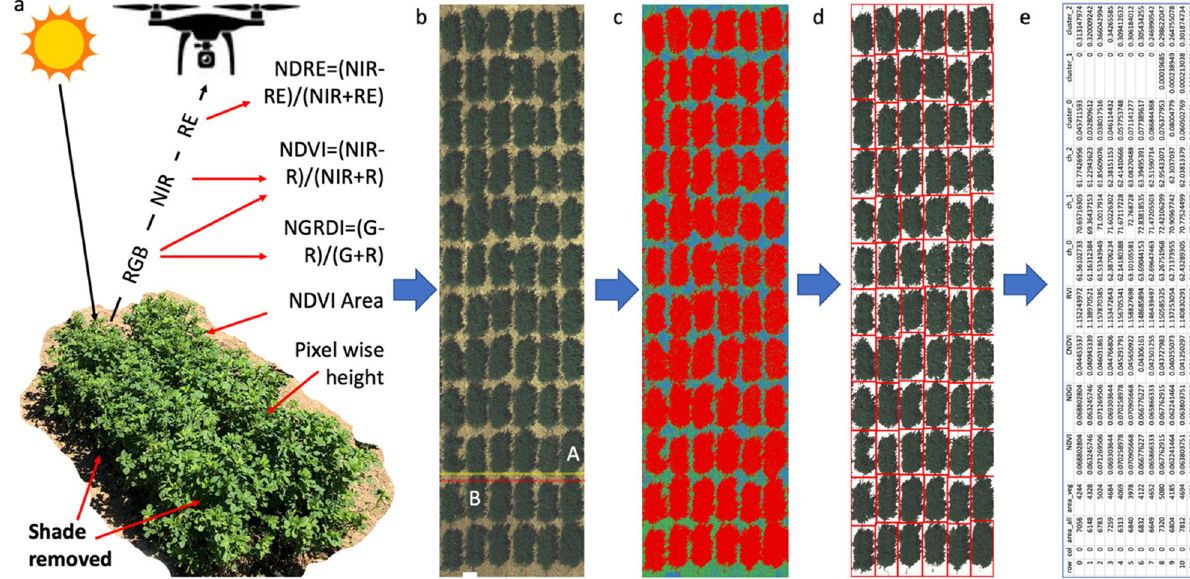
Figure 6. High-throughput phenotyping alfalfa biomass using UAV images. ( a ) The UAV-based imagery consists of five bands from the multispectral camera and pixel-wise plant height from the Pix4D, which can derive multiple Vegetation Indices (VIs) such as NDRE, NDVI, and NGRDI. The images with multiple bands are displayed as RGB ( b ). NDVI was used to cluster pixels into three classes ( c ). The class corresponding to the vegetation area (red) is selected to define pixels of interest and displayed in RGB ( d ). The plot information segmented by GRID is displayed for the plots in the first column ( e ). GRID can correctly segment plots that are not applicable using georeferences. For example, plot A and B cannot be separated by red and yellow lines, or any horizontal lines between them ( b